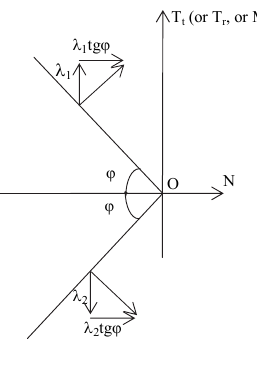
Figure 10: Yield domain for